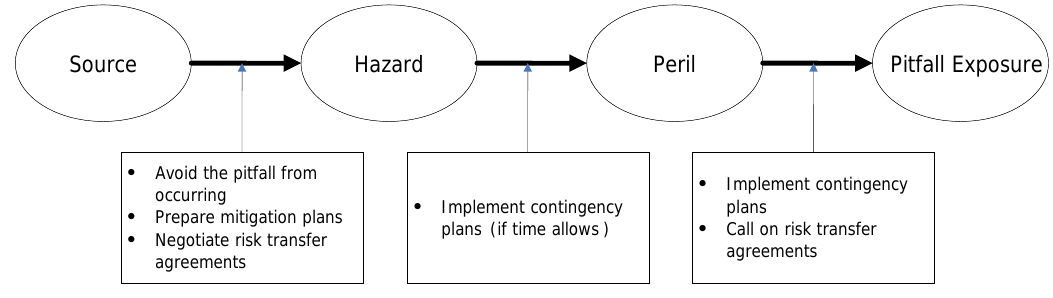
Figure 2. Acting upon pitfall components and events (based on Tchankova,